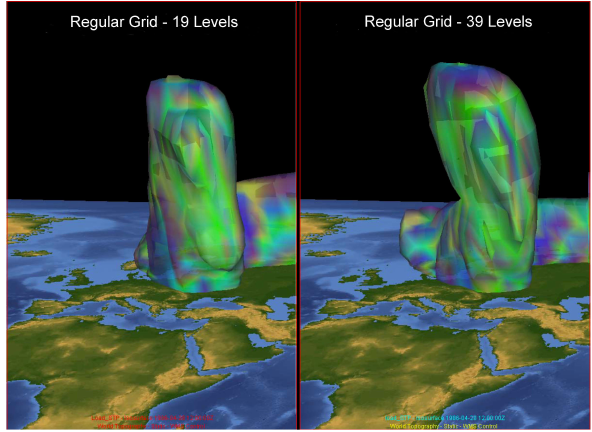
Fig. 7. A three-dimensional mapping of the 0.15Bqm − 3 STP iso- surface of 137 Cs on the third day after the Chernobyl accident (28 April, 12:00UTC) for 19 (left panel) and 39 vertical levels (right panel). Surface activity concentrations in Bqm − 3 STP are plotted on the iso-surface with the darker colour indicating high concentra- tions and the lighter lower